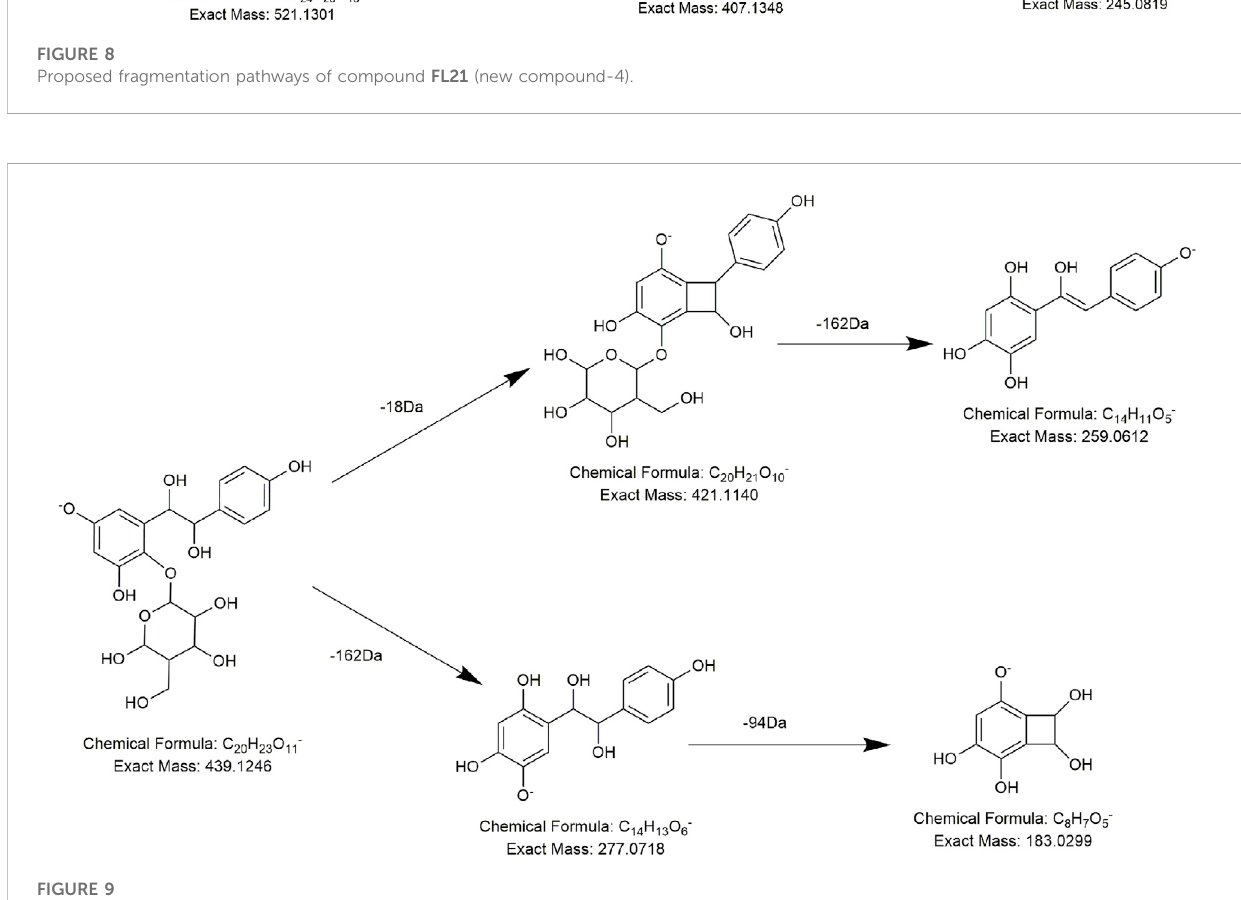
FIGURE 9 Proposed fragmentation pathways of D1 (new